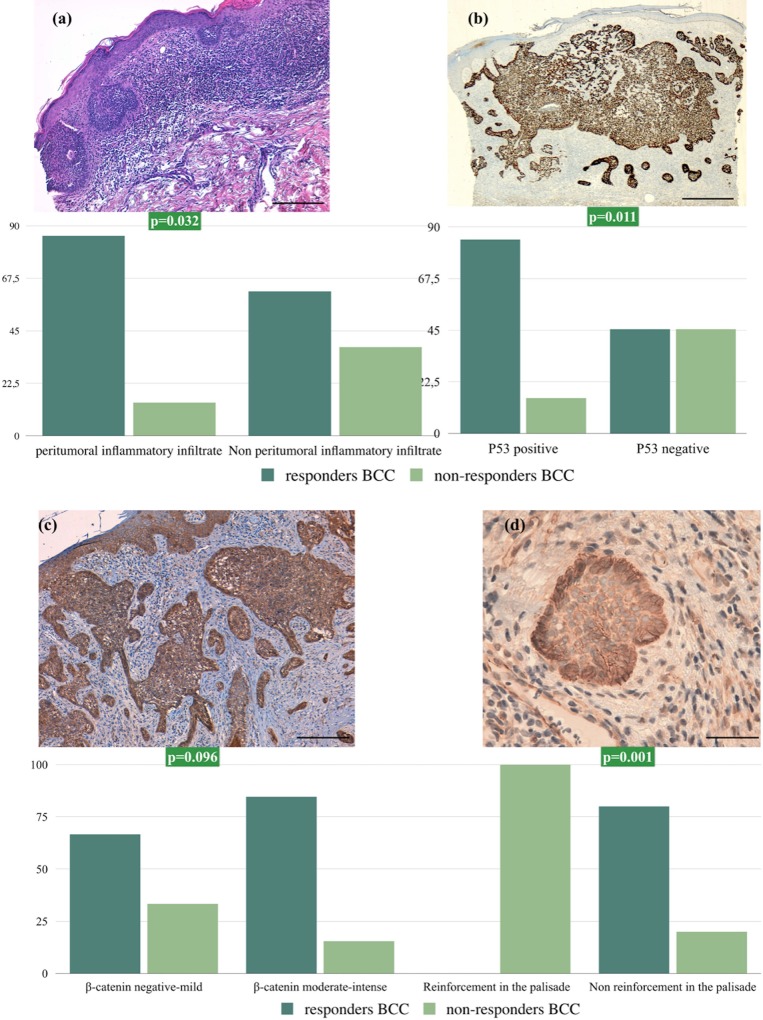
(a) Peritumoral inflammation surrounding basal cell carcinoma in a MAL-PDT-sensitive BCC (10×). (b) p53 immunostaining in a MAL-PDT responsive BCC: 97% of cells exhibit positive p53 immunostaining (5×). (c) Intense β-catenin immunostaining in a MAL-PDT-sensitive BCC (10×) and (d) enhanced peripheral palisading in a MAL-PDT-resistant BCC (40x). Bar charts depict levels of perilesional inflammatory infiltrate, p53 immunoexpression, and the intensity and distribution of β-catenin immunostaining in BCCs treated with MAL-PDT (responsive and nonresponsive). Scale bar: 200 μm (A and C), 500 μm (B) and 100 μm (D).